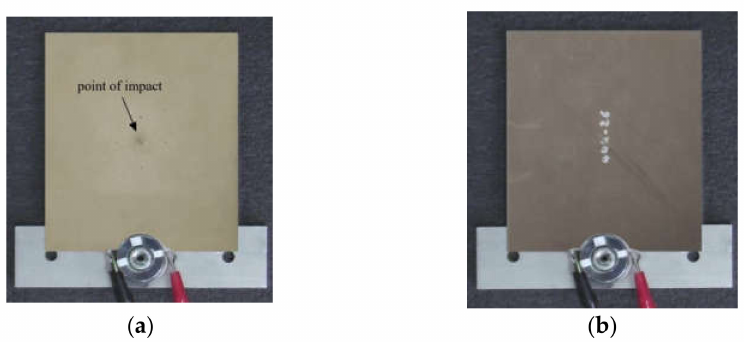
Figure 6. CFRP sample with 18 J impact damage: ( a )-front surface, ( b )-rear